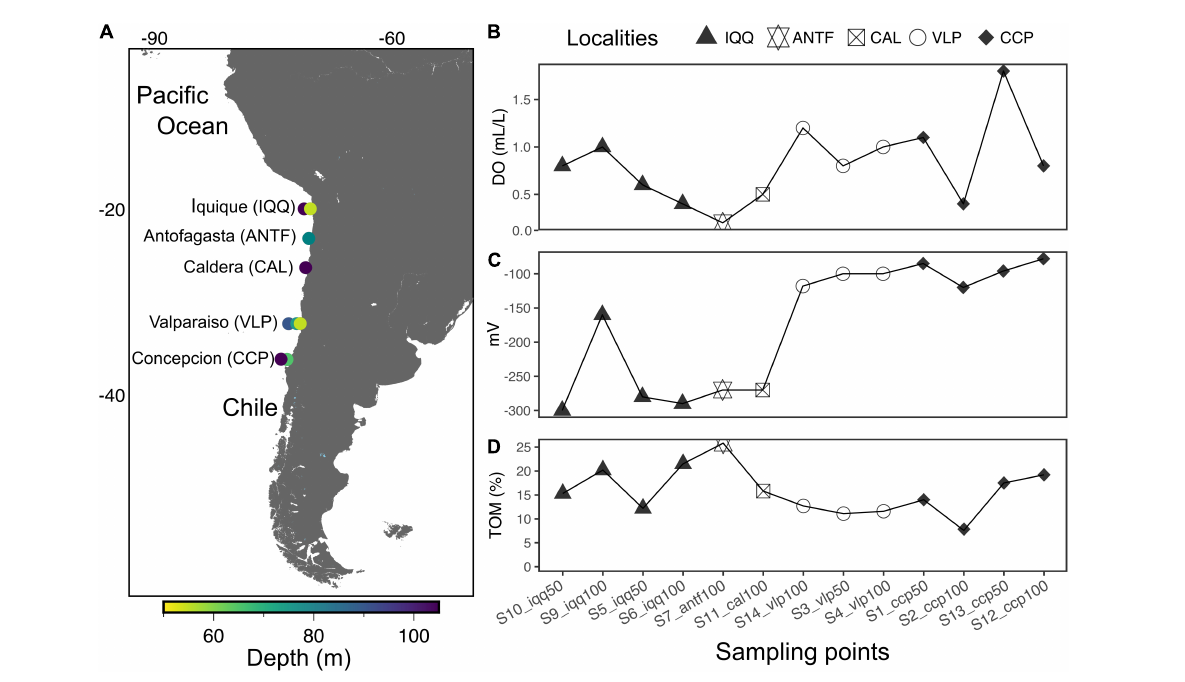
FIGURE1 (A) Map of sampling points. (B) Dissolved oxygen (DO) of bottom water in ml/L. (C) Average redox potential of the first 5 cm of sediment, measured in millivolts (mV). (D) Average total organic matter (TOM) in percentage of the first 5 cm of sediment.